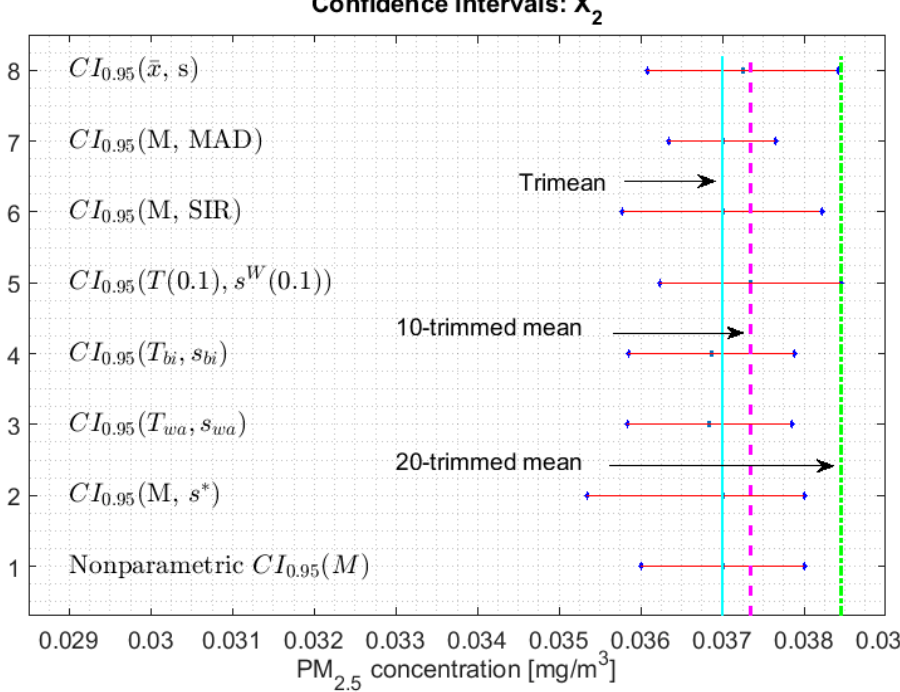
Figure 3. 95% confidence intervals ( CI 0.95 ) for robust and non-robust estimators: X 2 .